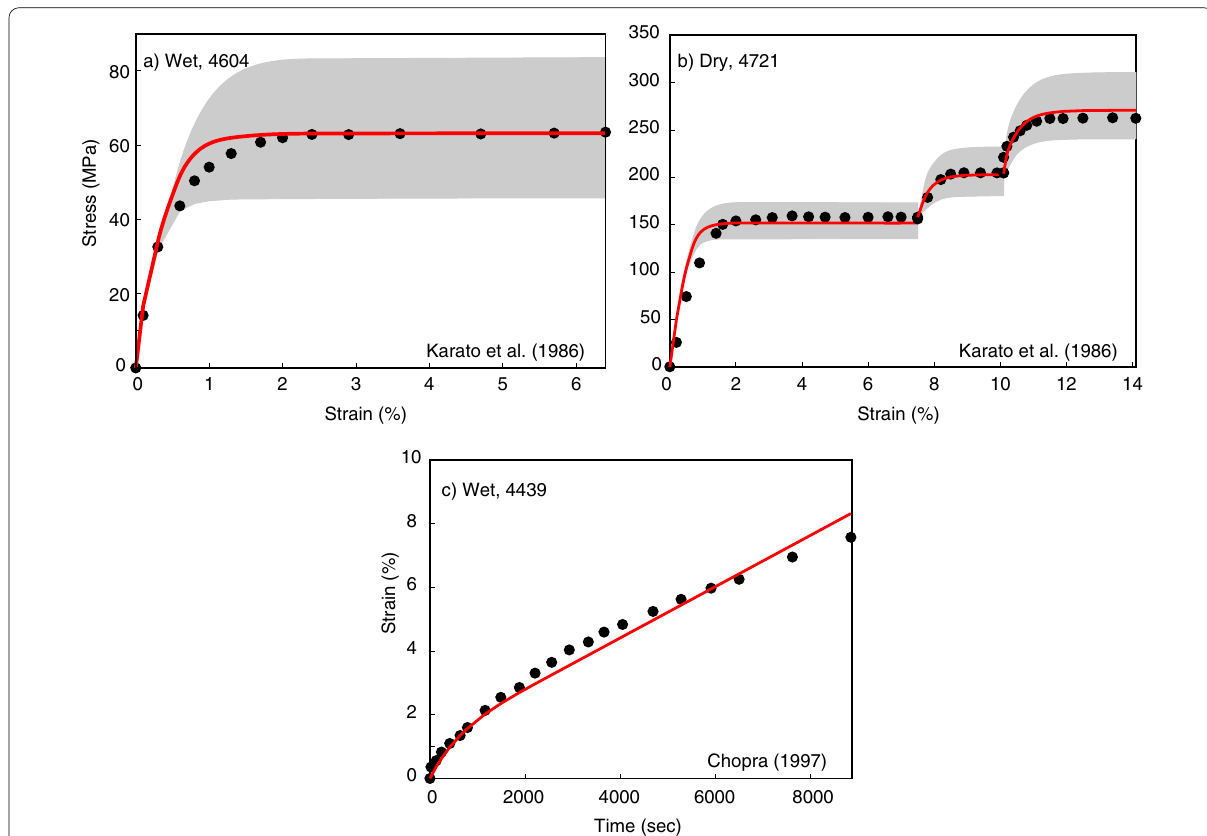
Fig. 9 Validation with other data. a , b Stress-versus-strain series (black dots) for San Carlos olivine aggregates from Karato et al. (1986) with best-fit model. The red line represents the best-fit model with the nonlinear Burgers rheology. The grey band represents the confidence interval. All the model parameters used are same as Tables 4 and 5, except for A K and A M (Additional file 1: Tables S3 and S4). c Constant stress experimental data of strain-versus-time series (black dots) for Åheim dunite from Chopra (1997) and best-fit model (red